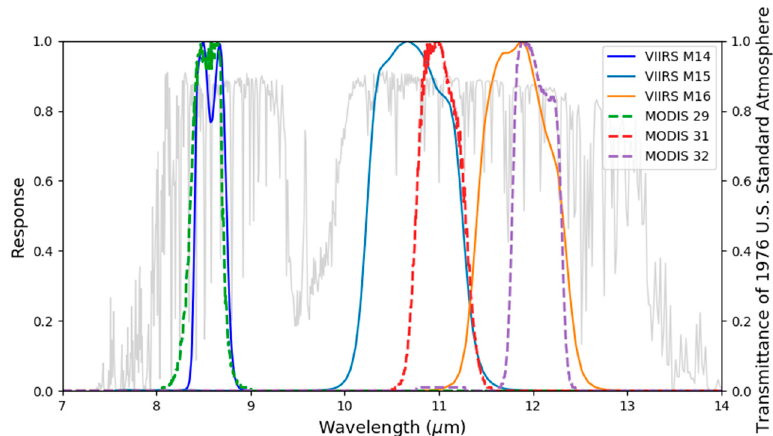
Figure 1. Relative spectral responses of Visible Infrared Imaging Radiometer Suite (VIIRS) channels M14, M15 and M16, and Moderate Resolution Imaging Spectroradiometer (MODIS) channels 29, 31 and 32. The gray line represents the transmittance of the 1976 U.S. Standard Atmosphere.